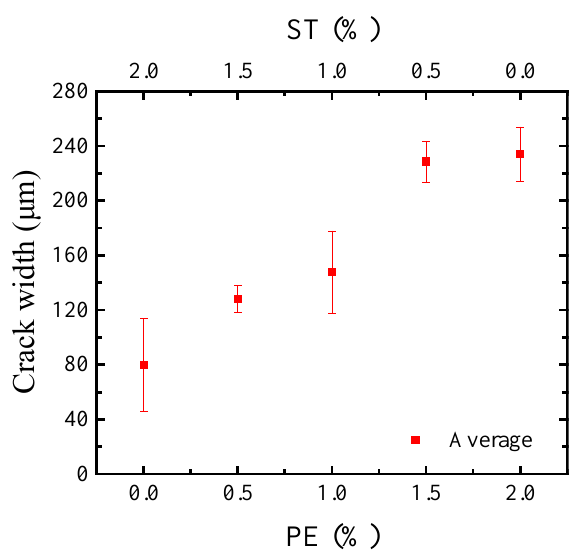
Figure 11. Average crack width of different volume fractions of PE and ST fibers.